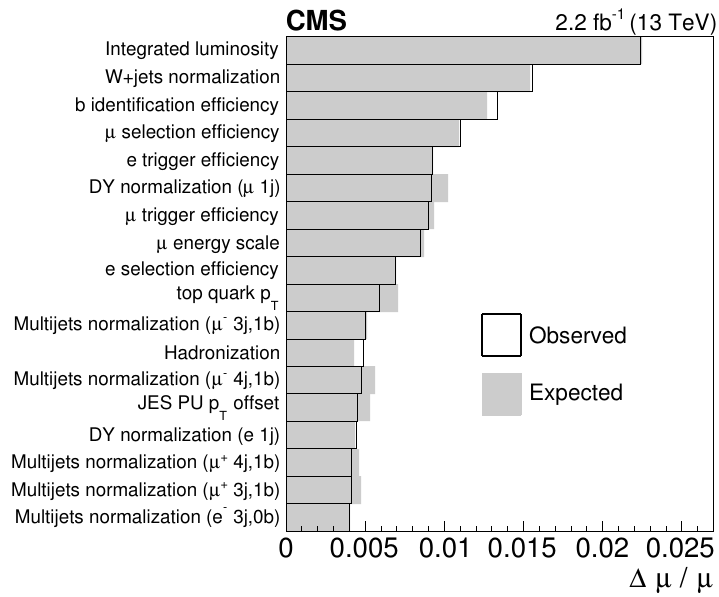
Figure 4 . Estimated change (cid:1) (cid:22) in the measured signal strength (cid:22) , coming from the listed exper- imental and theoretical sources of uncertainties in the main analysis. The open bars represent the values of the observed impact relative to the (cid:12)tted signal strength. The values are compared to the expectations (shaded bars) by performing the (cid:12)t using simulated events with m t = 172 : 5 GeV. The various contributions are shown from the largest to the smallest observed